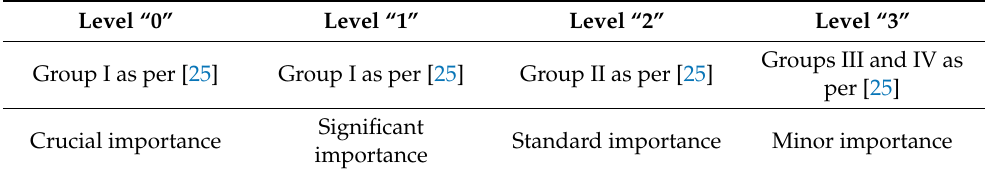
Group I as per [25] Group II as per [25]